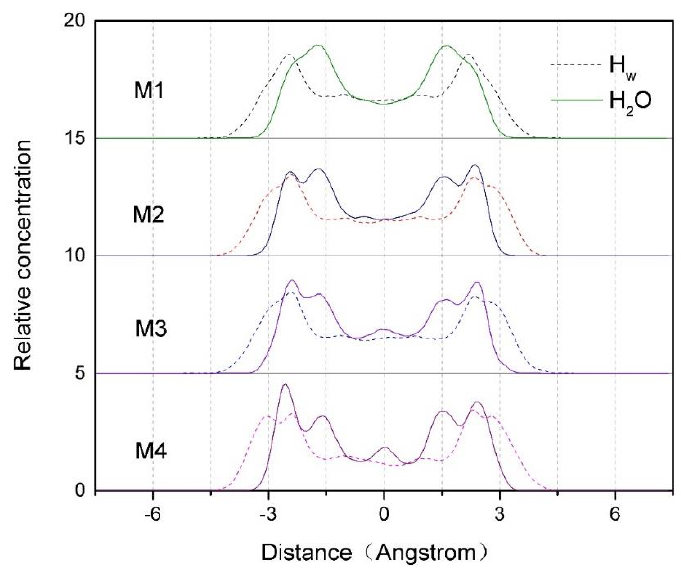
Figure 3. The Z-density profiles of water molecules and H W within the interlayer spaces of montmorillonites with di ff erent charge density.